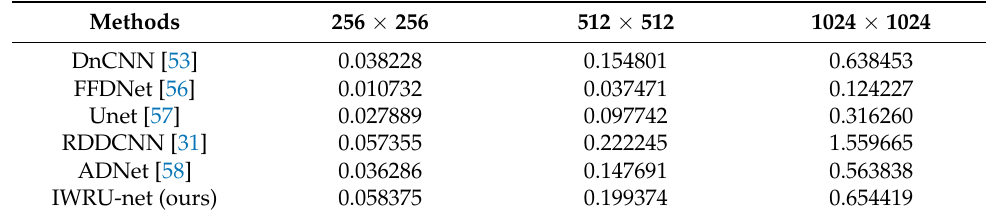
Table 6. Running time for different watermark removal methods on three image sizes.